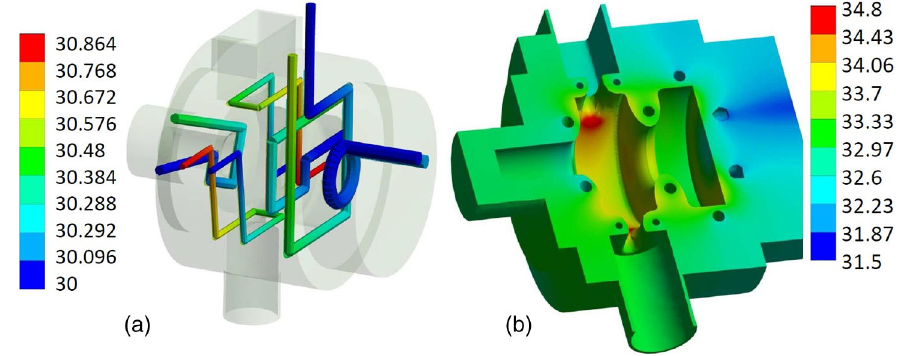
FIG. 8. Gun temperature distribution at regime: (a) water temperature into the cooling pipes; (b) gun body